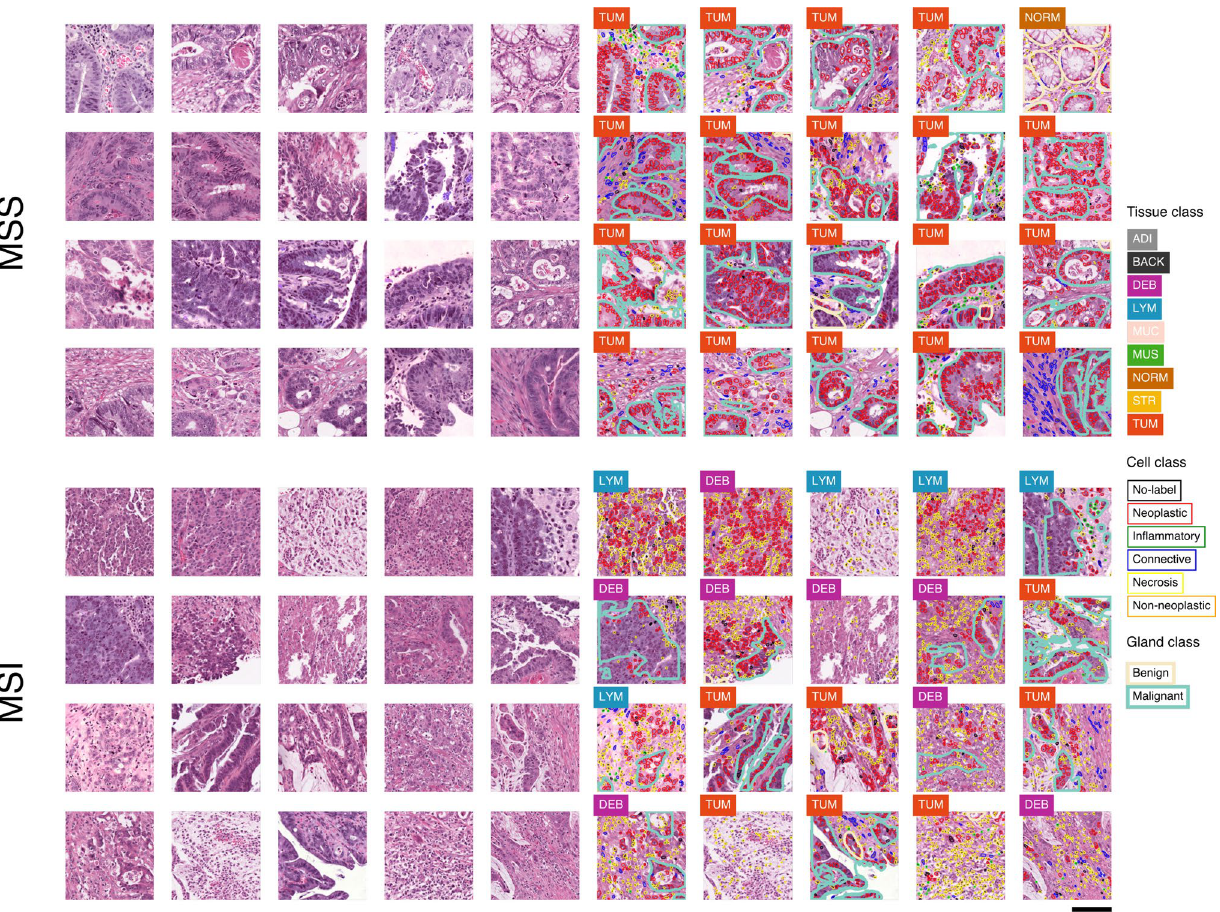
Figure 3. Examples of H&E image patches and predictions. Unprocessed patches from the test set of the colorectal (CRC) cohort alongside corresponding visualizations of tissue, nuclei, and gland predictions. The 20 highest and lowest MSI score patches, which do not overlap at the case-level, are shown as MSS (top) and MSI (bottom). MSS microsatellite stable, MSI microsatellite unstable (instability), ADI adipose tissue, BACK background, DEB debris, LYM lymphocytes, MUC mucus, MUS smooth muscle, NORM normal colon mucosa, STR cancer-associated stroma, TUM colorectal adenocarcinoma epithelium. Scale bar 50 µ m. The figure was generated using Inkscape v1.1 (https:// inksc ape.